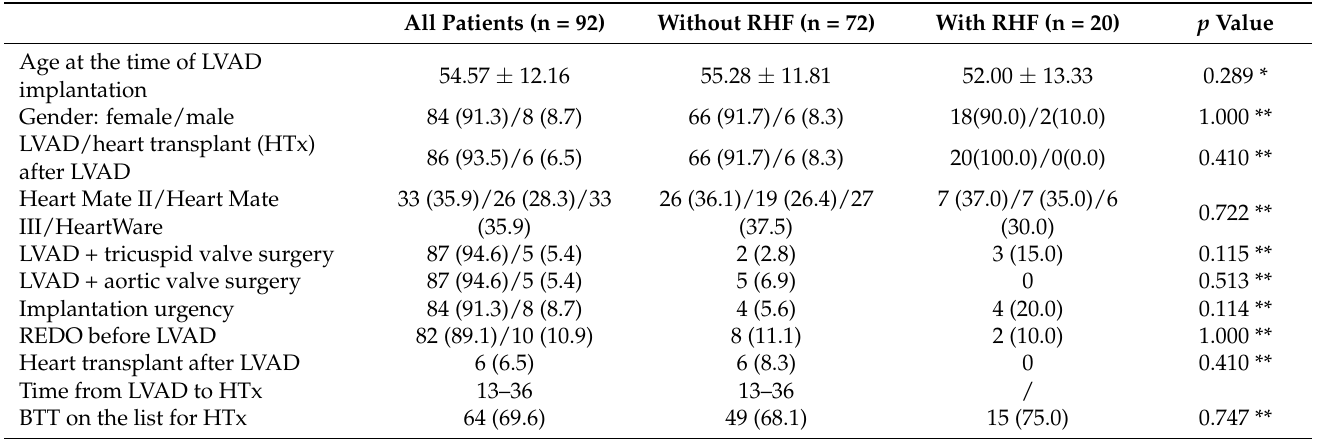
Table 5. Comparison of data of patients between who developed post-operative RHF with those who did not have RHF after LVAD